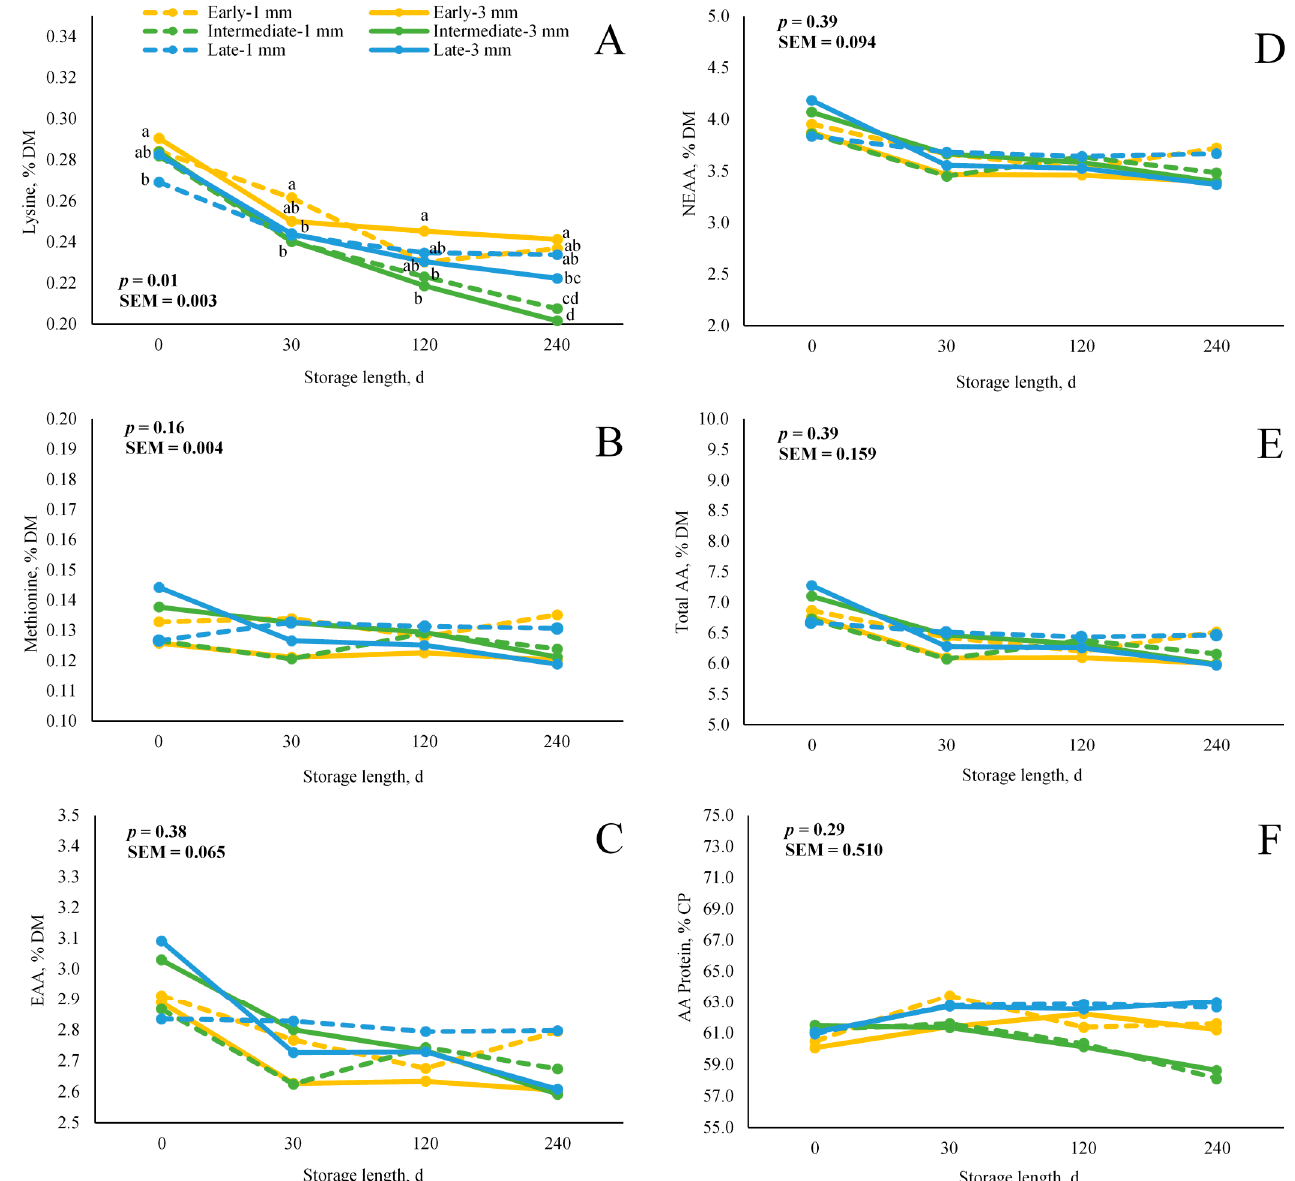
Figure 4. The effect of maturity, roll gap width, and storage length on lysine ( A ), methionine ( B ), EAA ( C ), NEAA ( D ), total AA ( E ), and AA protein (% CP) ( F ) concentrations in whole-plant maize silage ( n = 96). Means within the same day with different letters (a,b,c,d) differed ( p ≤ 0.05). Whole-plant maize was harvested at 3 maturities (1/4 (Early), 1/2 (Intermediate), and 3/4 (Late) kernel milk line) and processed through rolls with a gap width of either 1 or 3 mm using a self-propelled forage harvester. Silage was stored for 0, 30, 120, or 240 d.